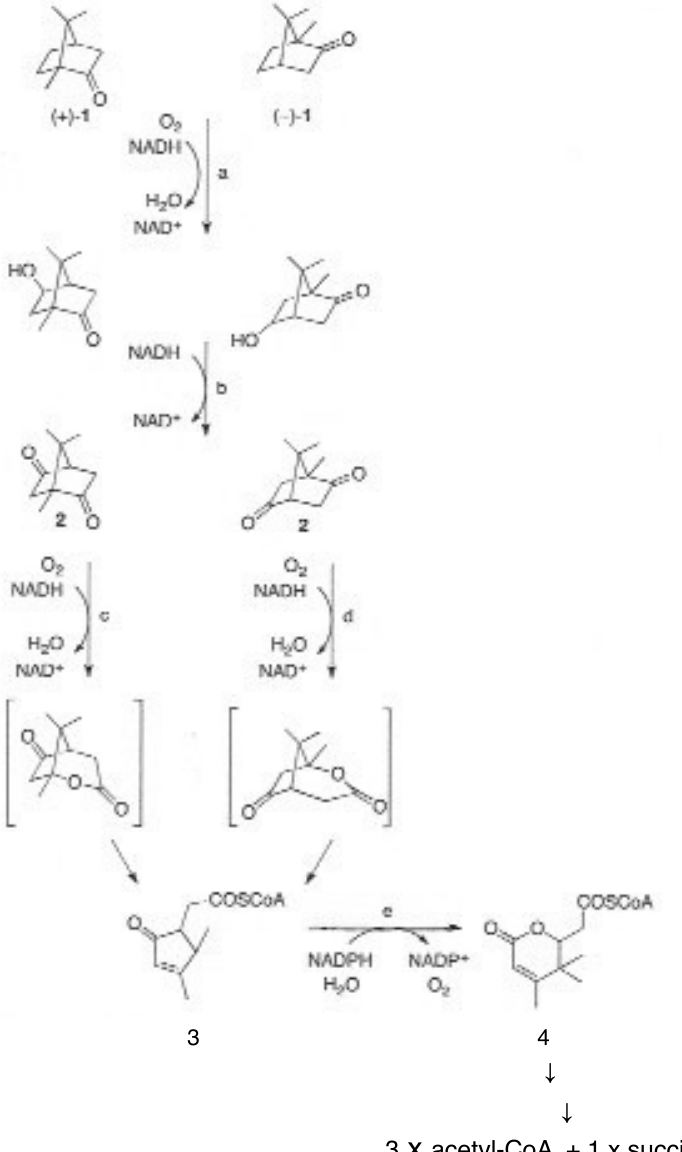
Figure 2. Dedicated pathway for the degradation of (+)- and (-)-camphor (1) by Pseudomonas putida ATCC 17453. Key idiosyncratic pathway intermediates shown are the enantiomeric dike- tocamphanes (2, DKCs), the monocyclic ketone 2-oxo- (cid:52) 3,4 -4,5,5-trimethylcyclopentenylacetyl-CoA (3, HTP-CoA) itself formed from the corresponding transitory free acid precursor OTE (2-oxo- (cid:52) 3,4 -4,5,5-trimethylcyclopentenylacetic acid), and the unstable monocyclic lactone 5-hydroxy-3,4,4- trimethyl- (cid:52) 2 -pimelyl- δ -CoA lactone (4). Subsequent hydrolysis of the monocyclic lactone generates the first aliphatic intermediate, a C10 carboxylic acid that is further metabolised to the TCA cycle inter- mediates acetyl-CoA and succinyl-CoA. The key sequential enzyme-catalysed steps are: a. camphor 5-monooxygenase ( camCAB ); b. exo hydroxycamphor dehydrogenase ( camD ); c. 2,5-diketocamphane 1,2-monooxygenase ( camE 25-1 + camE 25-2 ); d. 3,6-diketocamphane 1,6-monooxygenase ( camE 36 ); e. 2-oxo- (cid:52) 3,4 -4,5,5-trimethylcyclopentenylacetyl-CoA monooxygenase ( camG